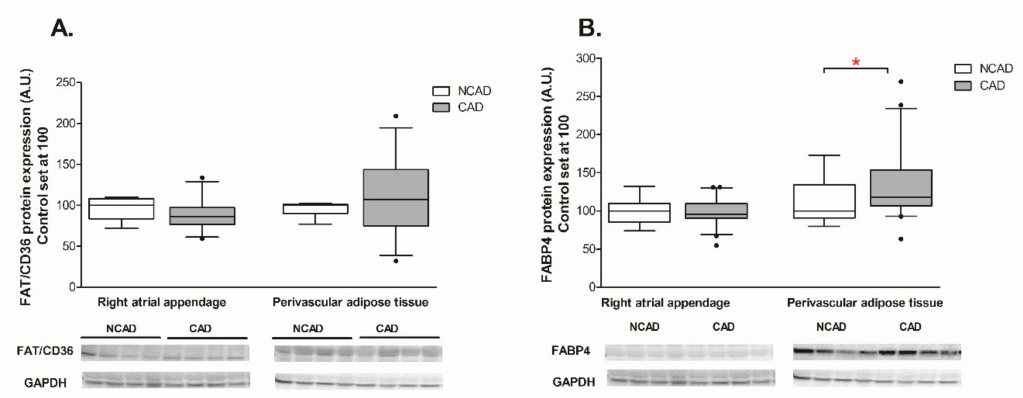
Figure 6. Myocardial and perivascular adipose tissue proteins expression of ( A ) fatty acid translocase (FAT / CD36), ( B ) fatty acid-binding protein 4 (FABP-4) in the coronary atherosclerosis (CAD, n = 42) and control (NCAD, n = 11) patients. Representative bands of WB analysis were shown. The inner horizontal line of a box represents the median. Box boundaries: 25–75 percentile; whiskers 5–95 percentile. Data are expressed as median ± SEM. For the sake of clarity, the control group median was set at 100, and the CAD group was scaled with respect to NCAD. * p < 0.05 vs. control